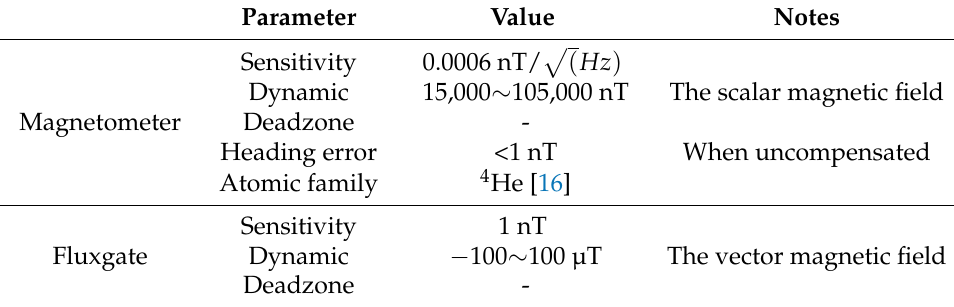
Table 1. Specifications of the magnetometer and fluxgate.